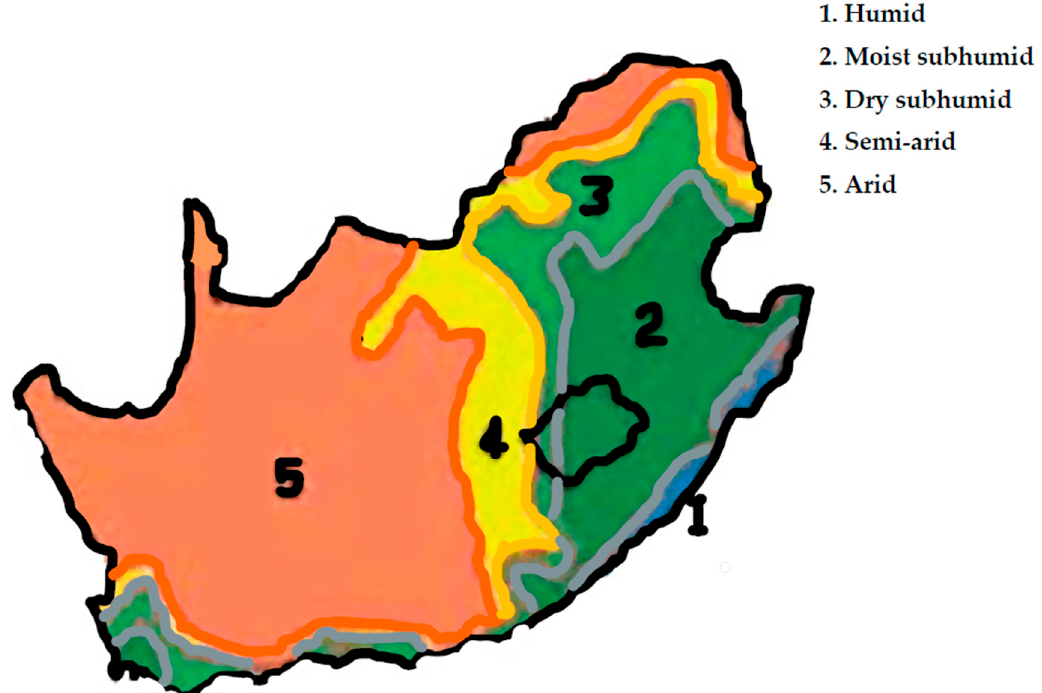
Figure 1 . Map of South Africa showing the different agro-ecologies. The Vhembe and Capricorn districts are in the Limpopo Province, in the arid (5) and dry sub-humid (3) regions, respectively. The ARC’s Roodeplaat Research Farm is located in the Gauteng Province, within the semi-arid (4) region (adopted from FAO [24]).